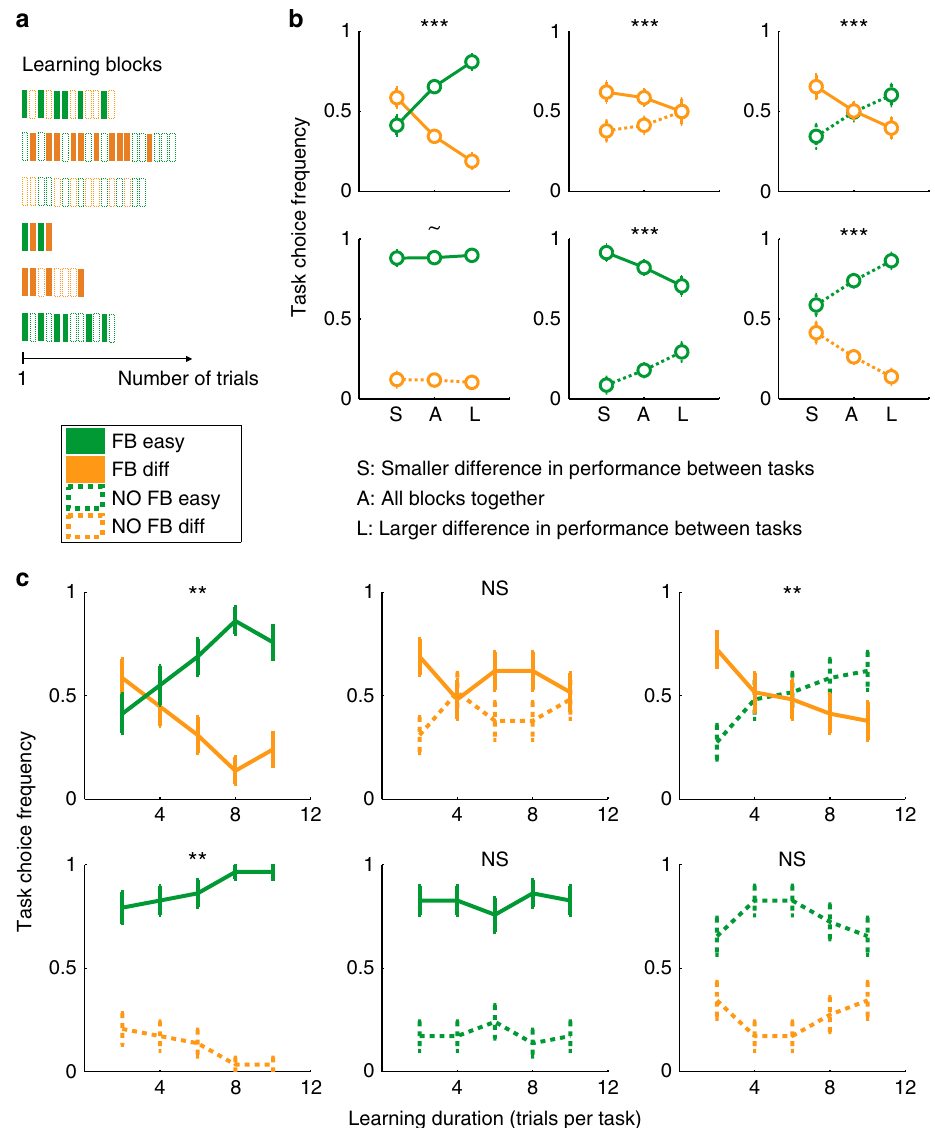
Fig. 4 Effects of performance and learning duration on global SPEs in Experiment 2 ( N = 29). a Experimental design. Block duration varied from 2 to 10 trials per task. b Task choice frequency in the six types of learning blocks. The central circle of each subplot represents the average task choice frequency over all blocks [ “ A ” ]. The left and right circles display the same data split into blocks with smaller [ “ S ” ] and larger [ “ L ”’ ] difference in objective performance between both tasks, indicating that fl uctuations in local performance in fl uenced SPEs over and above objective dif fi culty. ~ p = 0.076, *** p <0.0005 indicate the signi fi cance of the regression coef fi cient regarding the effect of the difference in task performance on task choice. c Task choice frequency as a function of block duration for the six task pairings. ** p <0.01 (resp. NS) denotes whether block duration had a signi fi cant (resp. not signi fi cant) in fl uence on task choice (statistical signi fi cance of the logistic regression coef fi cient, see Methods). Error bars indicate S.E.M. across subjects. See also Supplementary Fig.